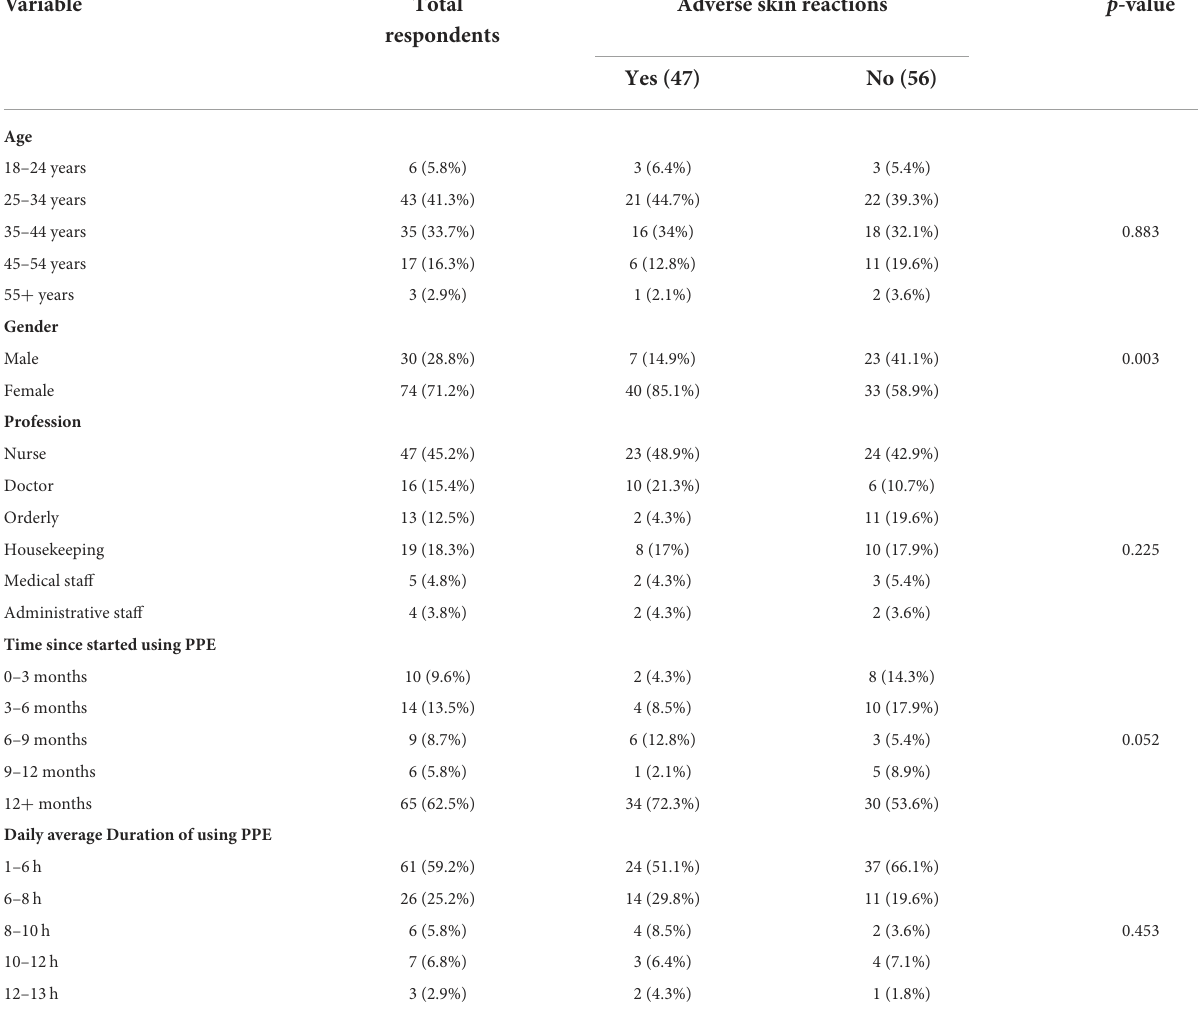
TABLE 1 Sociodemographic variables and prevalence of adverse effect in skin/face due to PPE use.